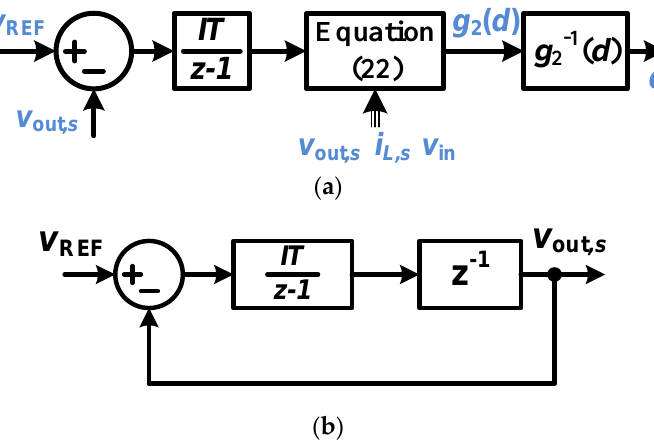
Figure 7. DPVP control with integral compensation: ( a ) Control scheme and ( b ) closed-loop equivalent model.